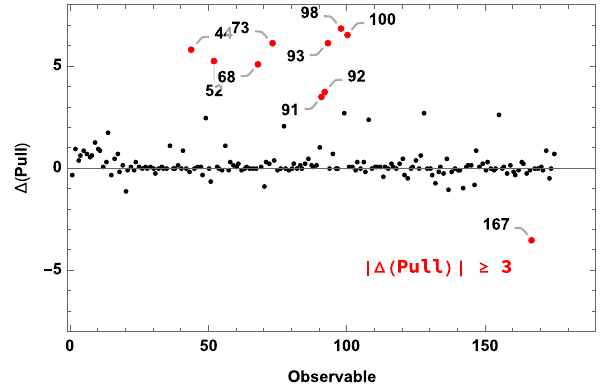
Fig. 13 (cid:11) 2 ( Pull ) for all observables close to zero for the BF prediction. In this case the details of the definition become